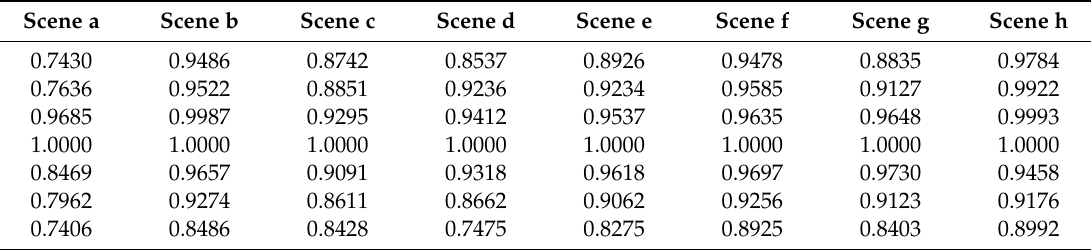
Table 2. The change of the Brenner function during focusing in di ff erent